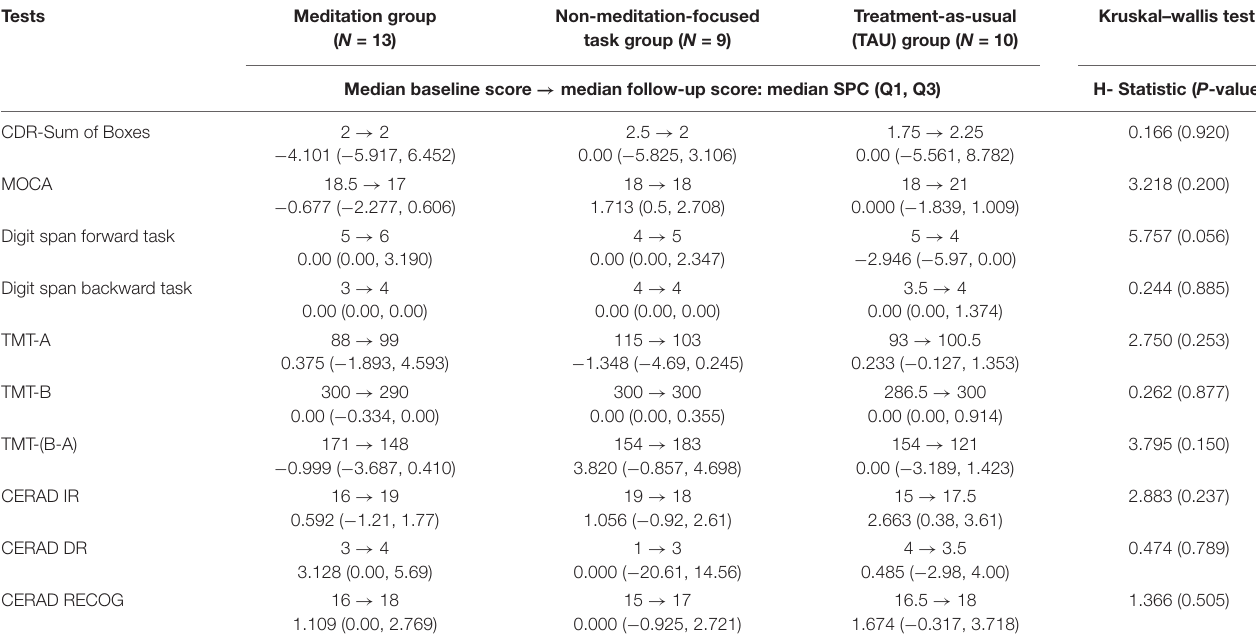
TABLE 2 | Neuropsychological scores (median value) from baseline to follow-up and “ Median (Q1, Q3) ,” “ H-statistic, ” and “ P-value